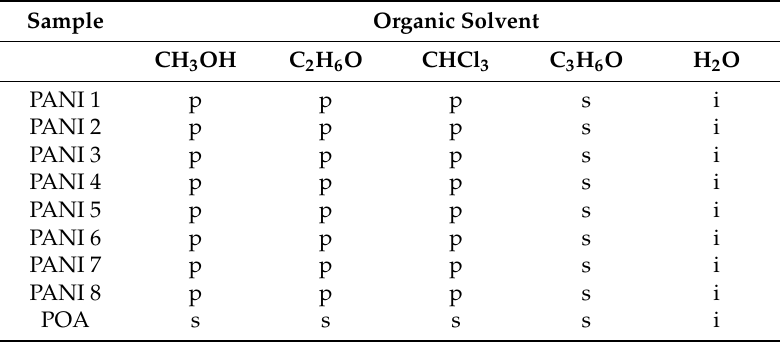
Table 6. Solubility of PANI and POA samples.